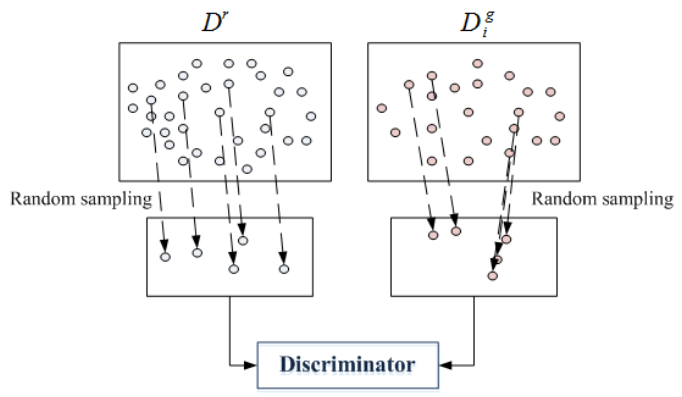
Figure 5. The ranges of two safety factors in each gear